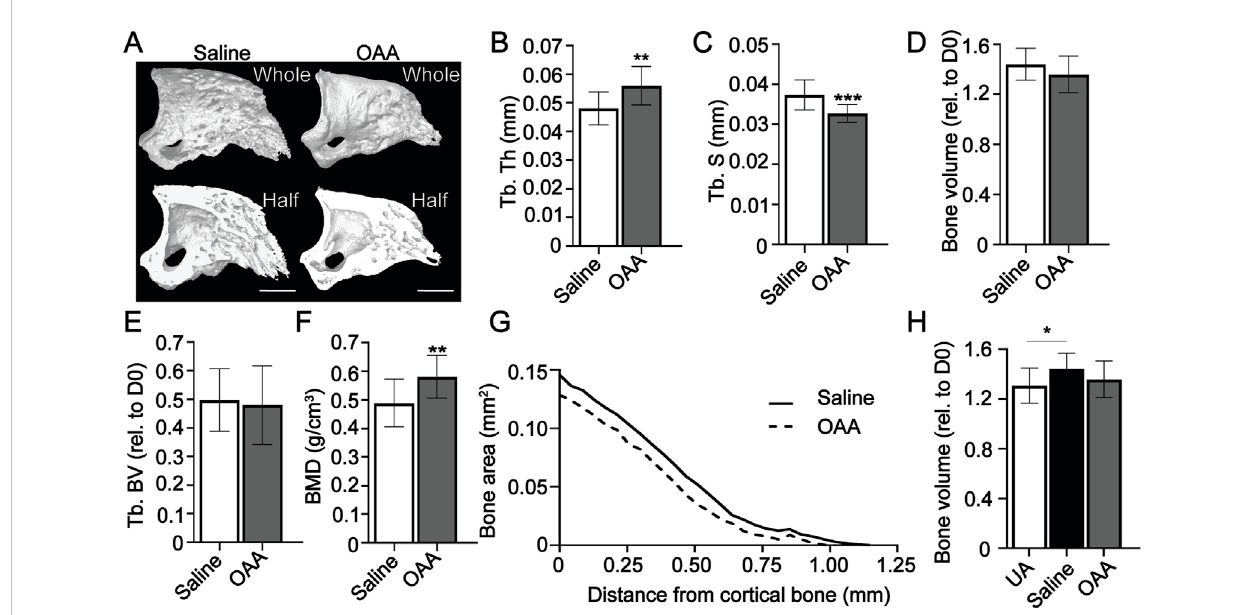
FIGURE 2 OAA enhances skeletal regeneration in young mice. (A) Radiographic images of whole and bisected digits in young mice at day 28 following administration of saline (Control) and OAA from day 10 – 28 following amputation of the distal P3. Bar 200 µm. Micro-CT quanti fi cation of (B) trabecular thickness (Tb. Th), (C) trabecular spacing (Tb. Sp), (D) bone volume (relative to day 0), (E) trabecular bone volume (Tb. BV) (relative to D0), (F) and bone mineral density (BMD). (G) 2D micro-CT analysis of regenerated bone from the remaining P3 cortical bone stump extending distally from saline control and OAA-treated mice. (H) Bone volume (relative to day 0) of saline controls and OAA-treated mice at day 28 compared to the bone volume of unamputated digits (UA). n = 15 digits/group. Graphs represent average values ± SD. * p < 0.05, ** p < 0.01, *** p <